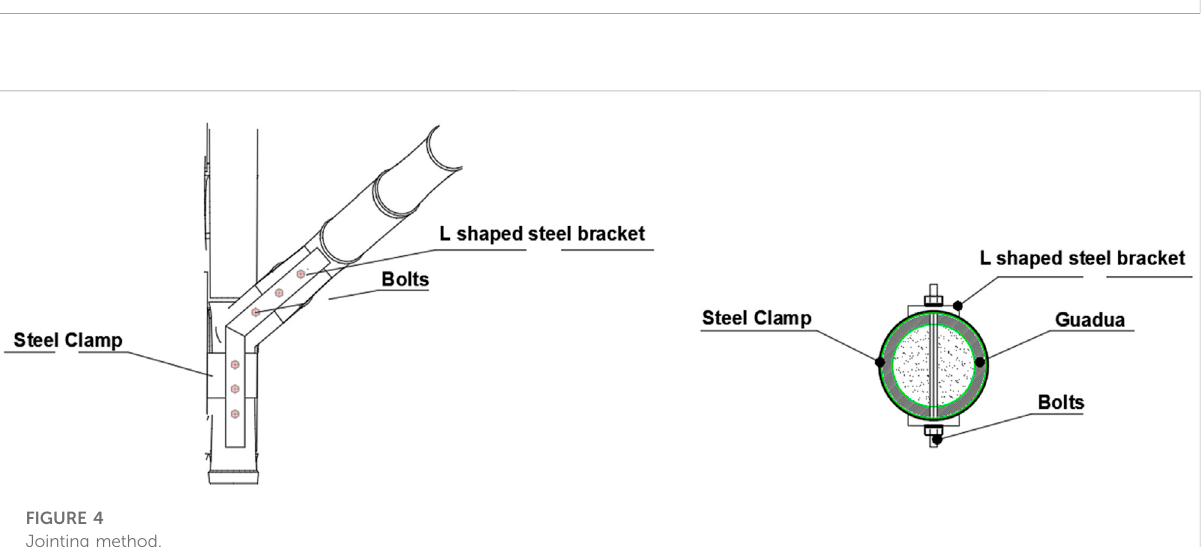
FIGURE 3 Cemented bahareque panel materials. Design inspired by the publication by López-Muñoz (2015).